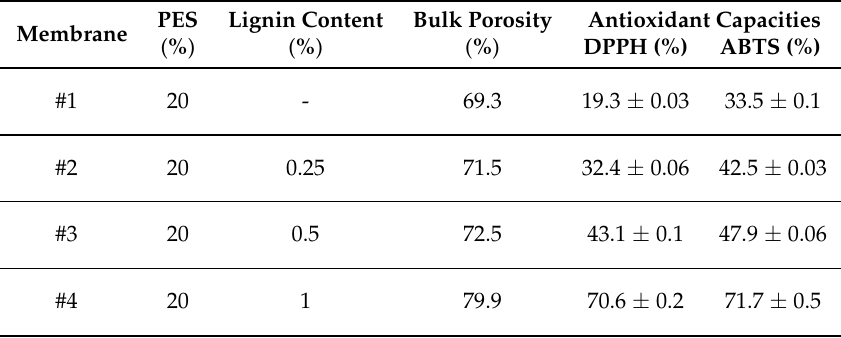
Table 1. The effect of DES-lignin on the bulk porosity, DPPH and ABTS antioxidant activity of fabricated membranes.